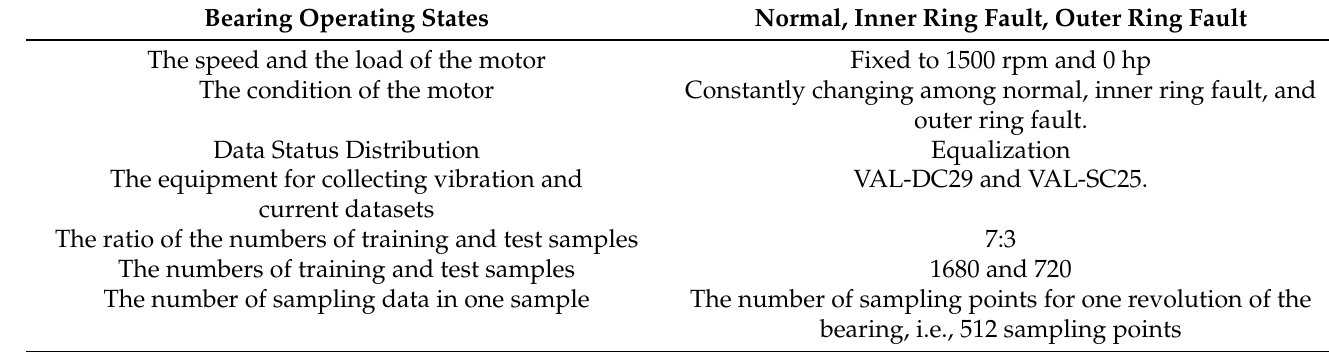
Table 2. Details related to data